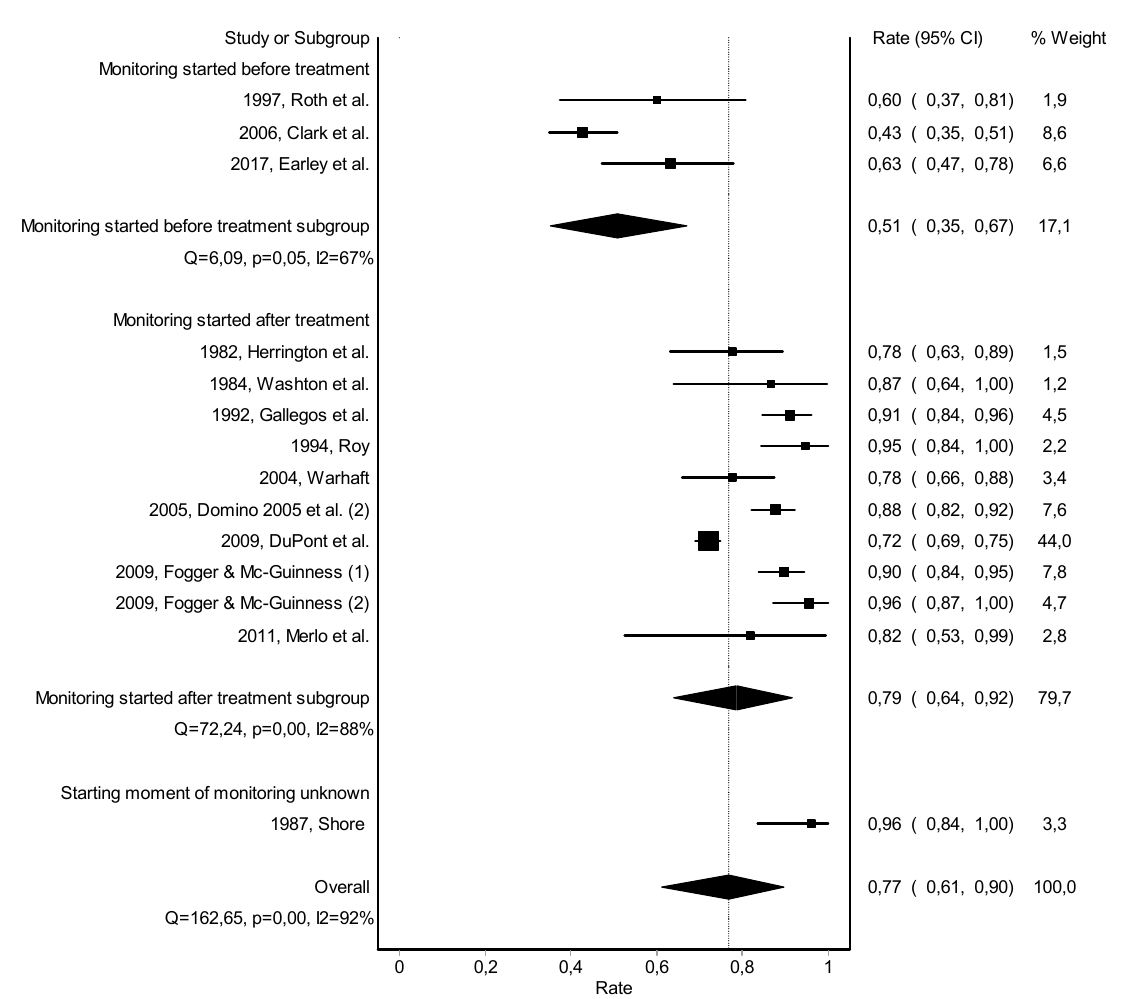
Figure 3. Forest plot of the pooled work retention rate—subgroup analysis based on starting moment of monitoring.